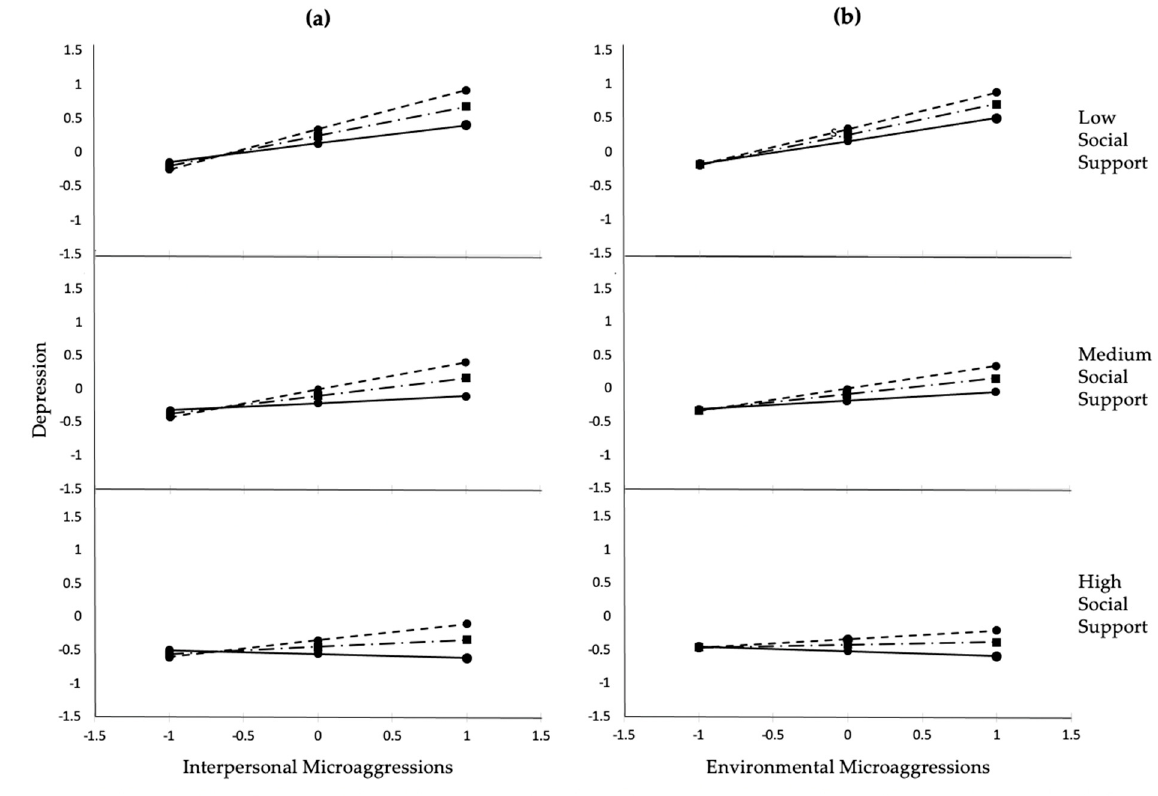
Figure 3. Conditional effects of multiple moderation analyses ( n = 134). ( a ) Conditional effect of interpersonal microaggres- sions on depressive symptoms as a function of social support and comfort from companion animals; ( b ) conditional effect of environmental microaggressions on depressive symptoms as a function of social support and comfort from companion animals. All the variables of interest were standardized .